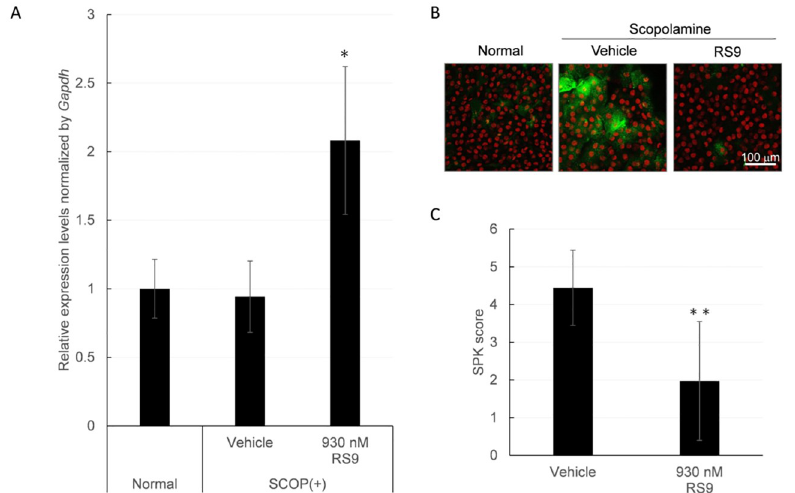
SPK score by RS9 in the corneal epithelium of scopolamine-treated rats. A, 2 weeks of topical administration of RS9 significantly induced Nqo1 mRNA expression in scopolamine-treated rats. Data are presented as the mean ± SD (N = 2–6). � P < 0.05, compared with normal. B, Immunohistochemistry of 8-OHdG was performed in the corneas of scopolamine-treated rats. Confocal microscopic analysis of corneal epithelial cells were performed after immunostaining of 8-OHdG (Green) and TOPRO nuclear staining (Red). Immunostaining of 8-OHdG accumulated in scopolamine-treated rats and was reduced by RS9 topical administration. Representative data are shown. C, Superficial punctate keratitis (SPK) score was evaluated by fluorescein staining. SPK scores were decreased after topical administration of RS9. Integrated data from two trials are shown. Data are the means ± SD (N = 10). �� P < 0.01, compared with vehicle, Student’s t